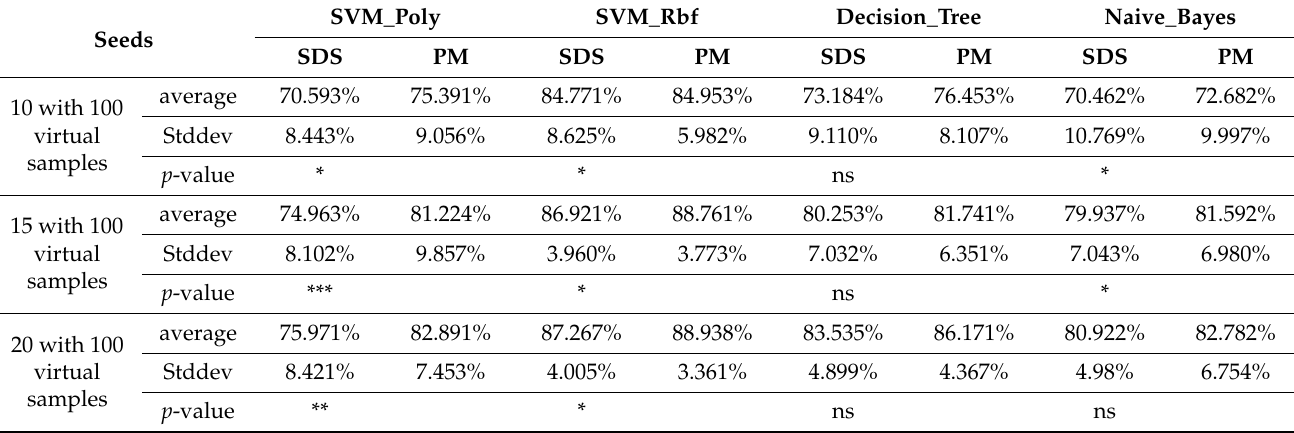
Table 5. The result of generating 100 virtual samples by WGAN_MTD for the Cervical Cancer